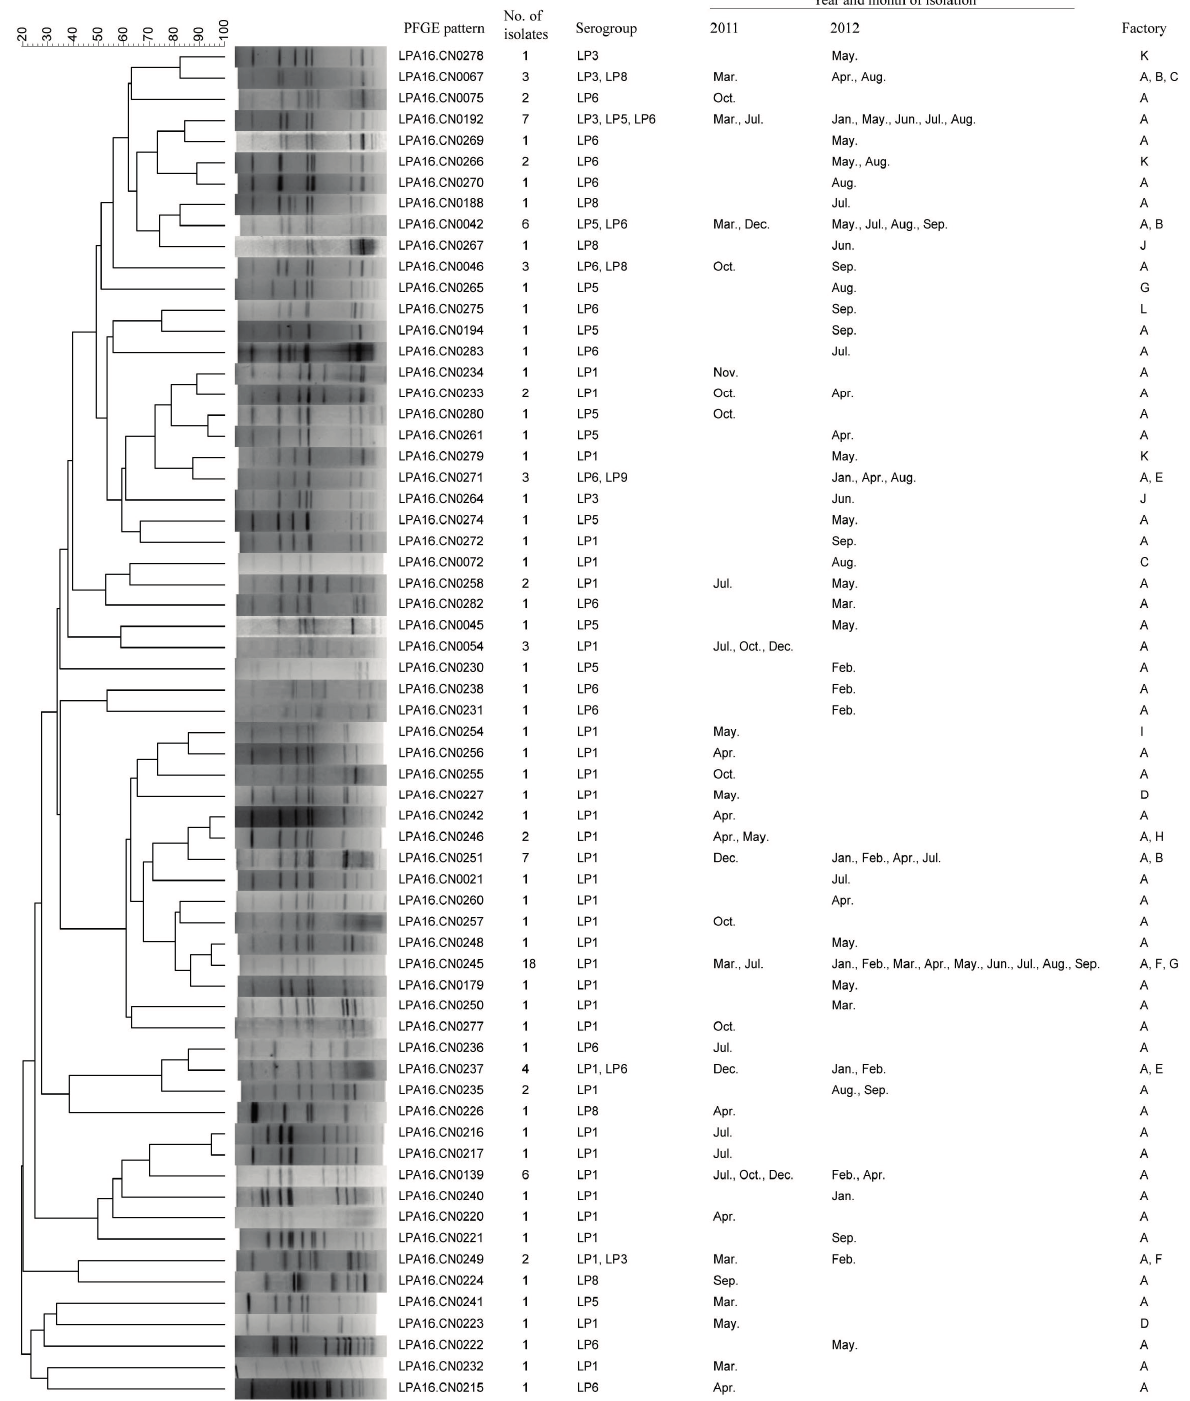
Figure 2. Clustering results of patterns obtained by pulsed-field gel electrophoresis (PFGE) analysis of 121 Legionella pneumophila strains. These strains were isolated from industrial cooling towers in Shijiazhang, China during the 19-month study